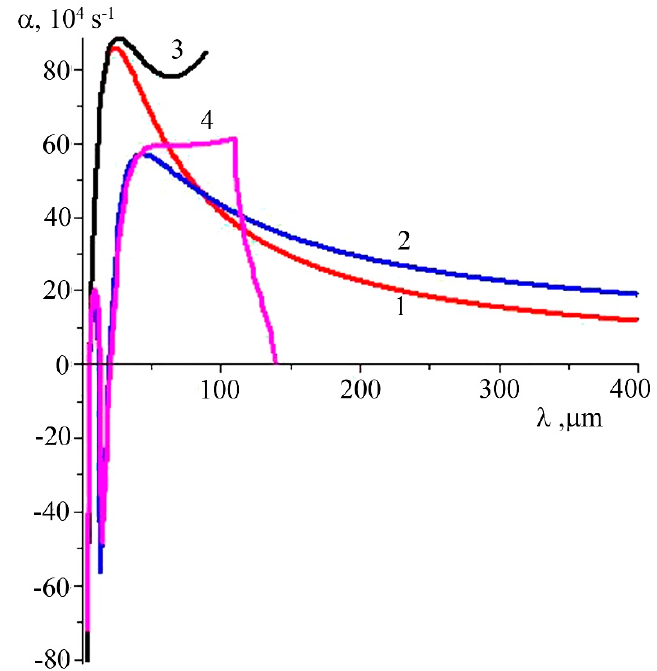
Figure 7. A growth rate characteristic of perturbations on the plasma–silumin melt interface for a gradient of surface concentration of 10 m − 2 /m found when solving the Equation (11): ( 1 ) ignoring thermoelectric and evaporation and capillary effects, ( 2 ) including the thermoelectric effect only, ( 3 ) with regard to thermal and evaporation and capillary instabilities, ( 4 ) involving thermal, evaporation and capillarity instabilities and the thermoelectric effect.